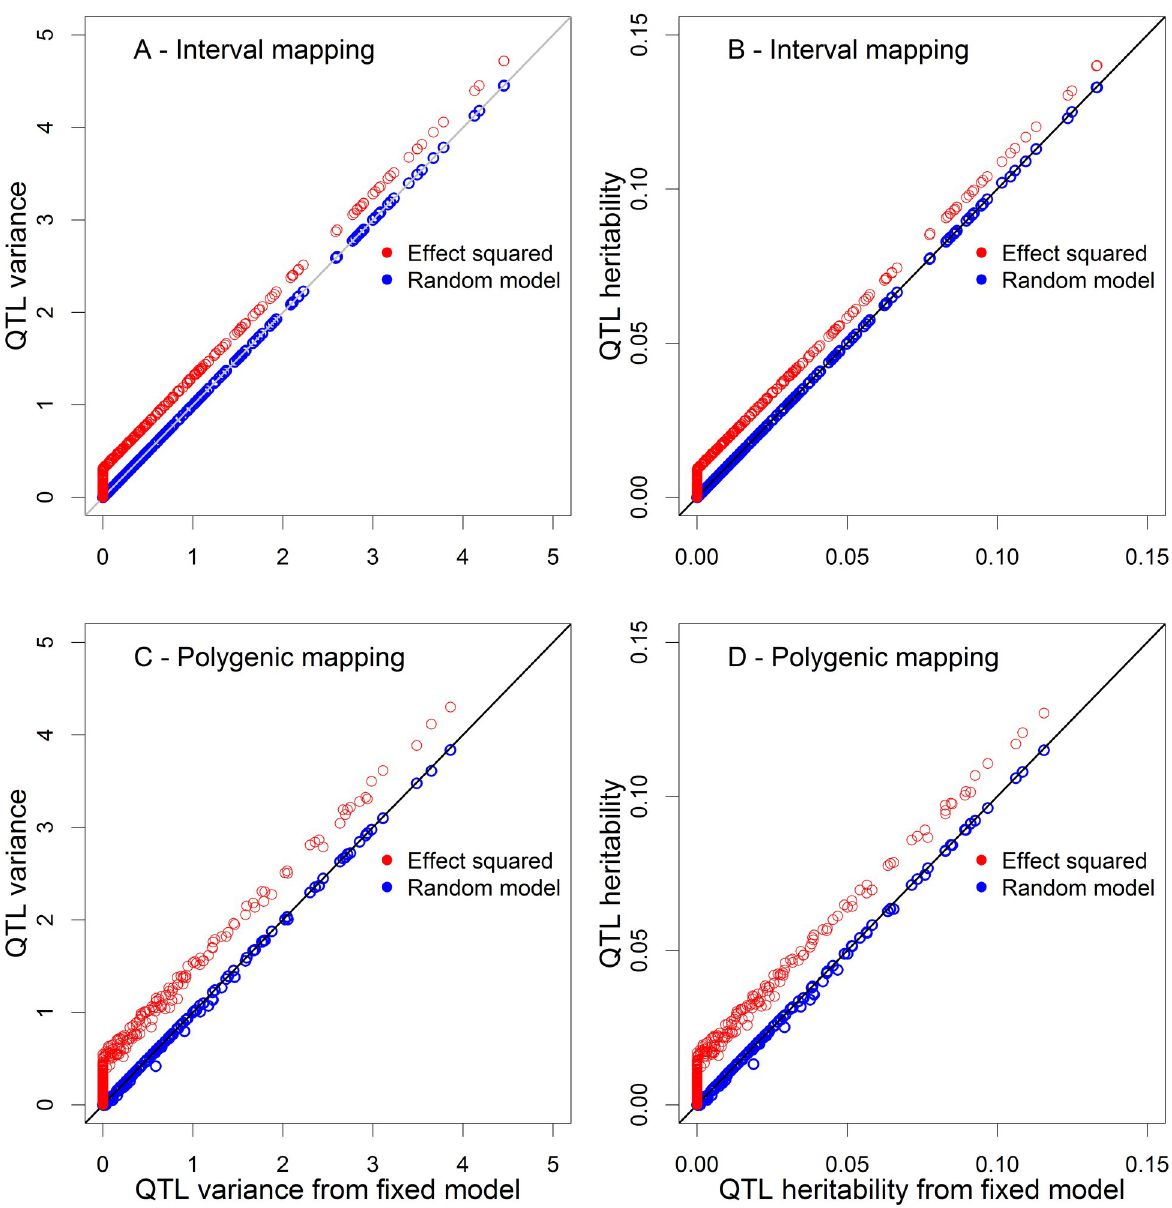
Fig 6. Comparison of QTL variance and heritability from three estimation methods (squared, random model and fixed model). (A) and (B) Plots of estimated QTL variance and heritability from the square method and the random model method against the estimates from the fixed model approach for interval mapping. (C) and (D) Plots of estimated QTL variance and heritability from the square method and the random model method against the estimates from the fixed model approach for polygenic mapping.